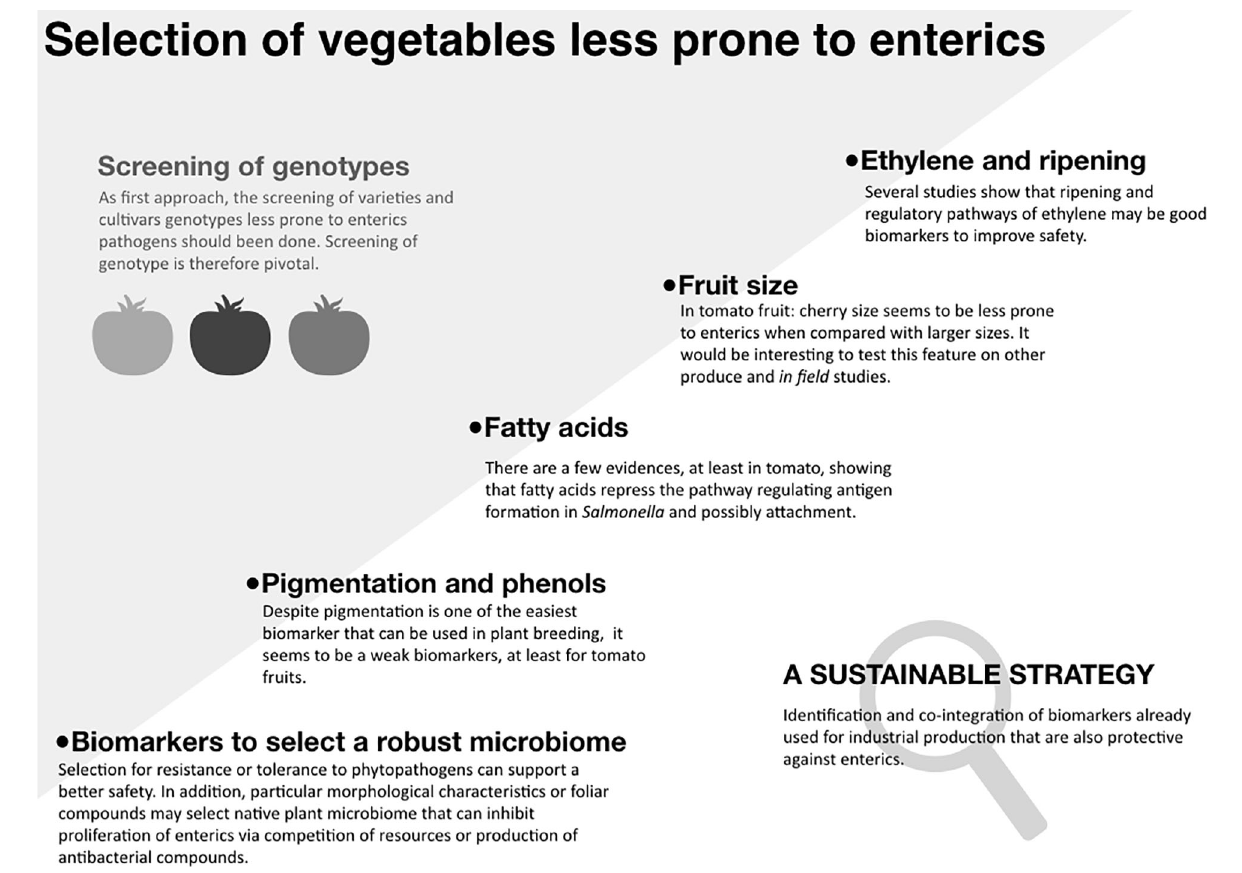
FIGURE 1 | Selection of vegetables less prone to enteric pathogens. “Screening of genotypes”: The gray shadow panel shows that within same species there is a significant variability to the proliferation of enterics. Such different susceptibility can be the result of specific genetic traits that can be inherited by the offspring. The diagram shows the current advances in this direction, speculating which biomarkers may be the most promising. “Sustainable strategy” panel: To give an example, in tomato, some of the ripening related genes that are already used to increase shelf life could be used to develop vegetables less prone to enteric pathogens (Bai and Lindhout,